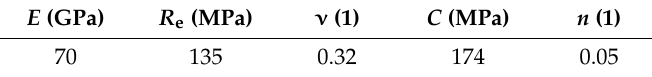
Figure 2. ( a ) The main details and dimensions of micro-upsetting; and ( b ) SEM of the specimen. Legend: (1) the specimen; (2) the anvil; (3) the punch; and (4) the limiting plate, which was optional. Table 1. Mechanical properties of specimen materials.